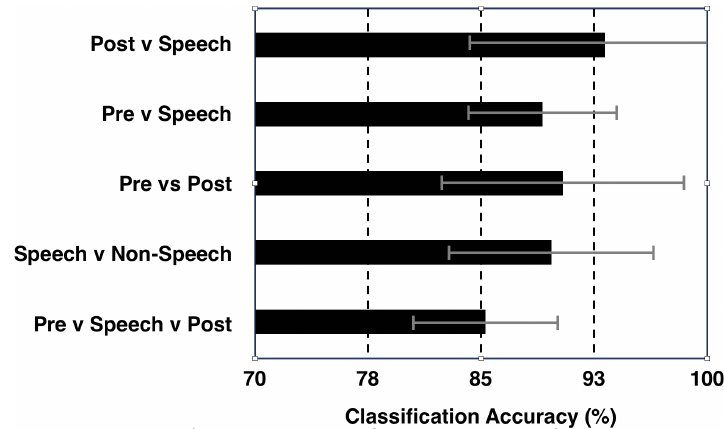
Figure 4. Results of classification between Pre-, Post-, and Speech segments; Error bars show the standard deviation across 8